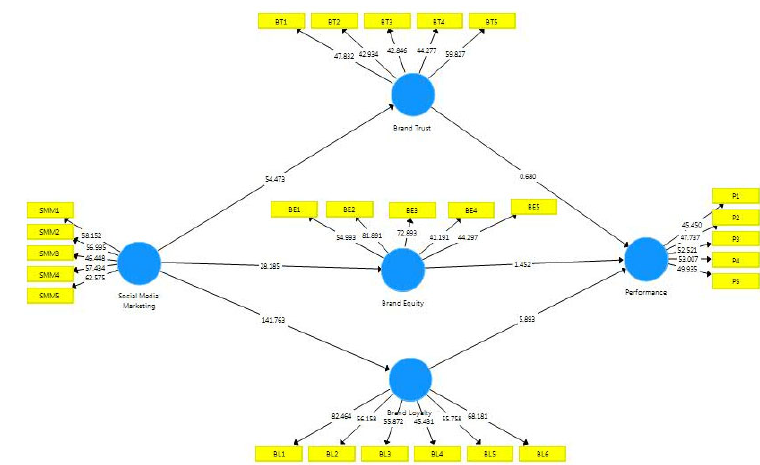
Fig. 3. Hypotheses Testing